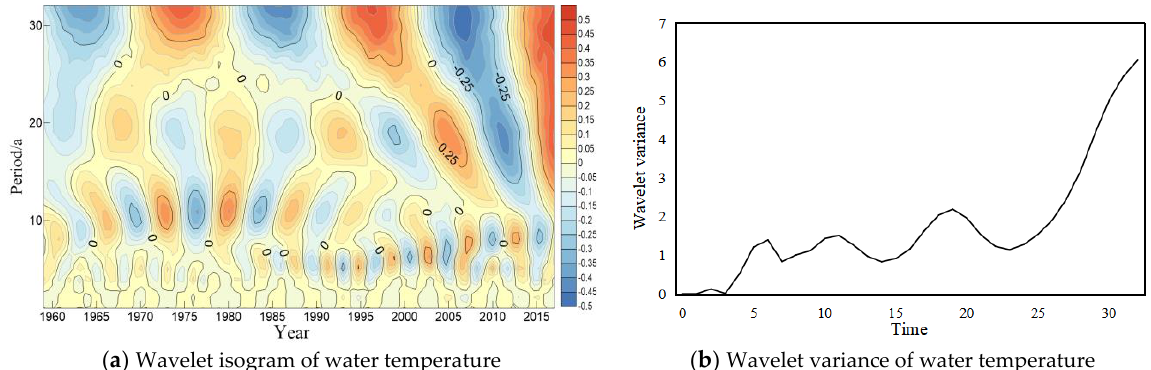
Figure 5. Wavelet isogram (a) and wavelet variance map (b) of water temperature at Yichang station.